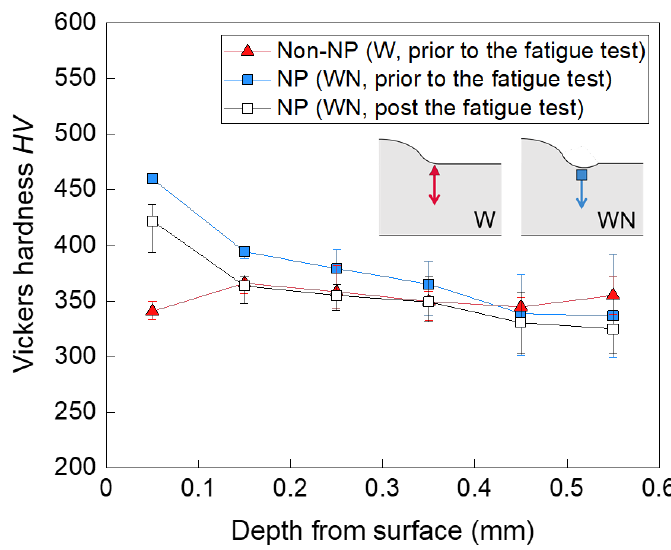
Figure 9. Vickers hardness profiles. In-depth hardness profiles of the weld toe at the surface layer of W and WN prior to the fatigue test were measured. The hardness profile of WN after the fatigue test at a fatigue limit of σ w = 240 MPa was also measured.